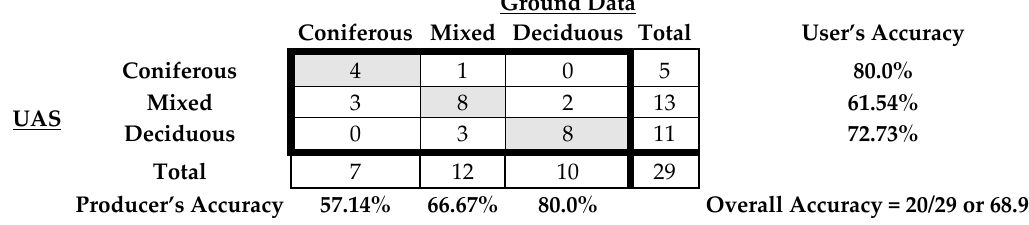
Table 3. Stratified random sampling PBC thematic map error matrix. Ground (reference) data are represented by the CFI plots and Unmanned Aerial Systems (UAS) data are derived from the corresponding orthomosaic.